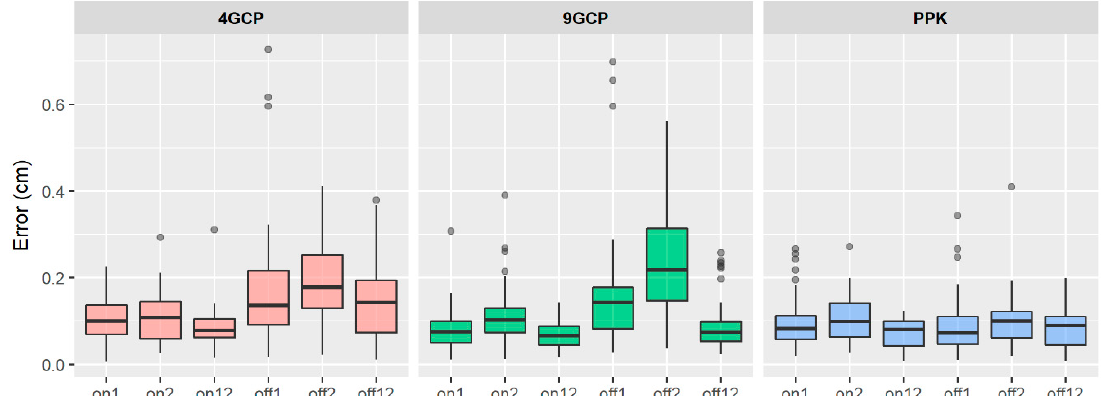
Figure 5. Boxplots represent horizontal errors separated by georeferencing method and divided by the seasons and flight patterns (horizontal line represents median, the lower part of hinge represents the 25th percentile and upper part represent 75th percentile, whiskers represent 1.5 × IQR (interquality range) in both directions) acquired on point clouds.